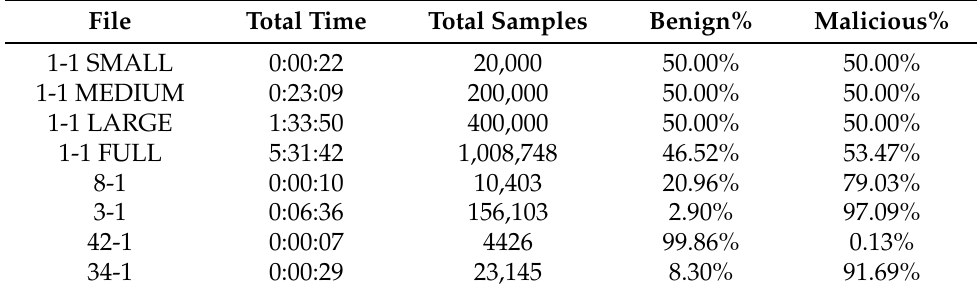
Table 3. Datasets used.